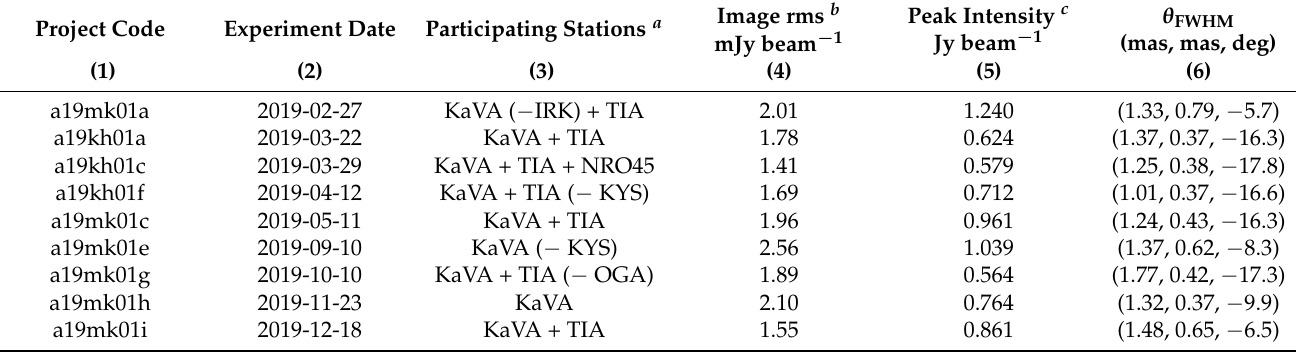
Table 1. Summary of the EAVN observations